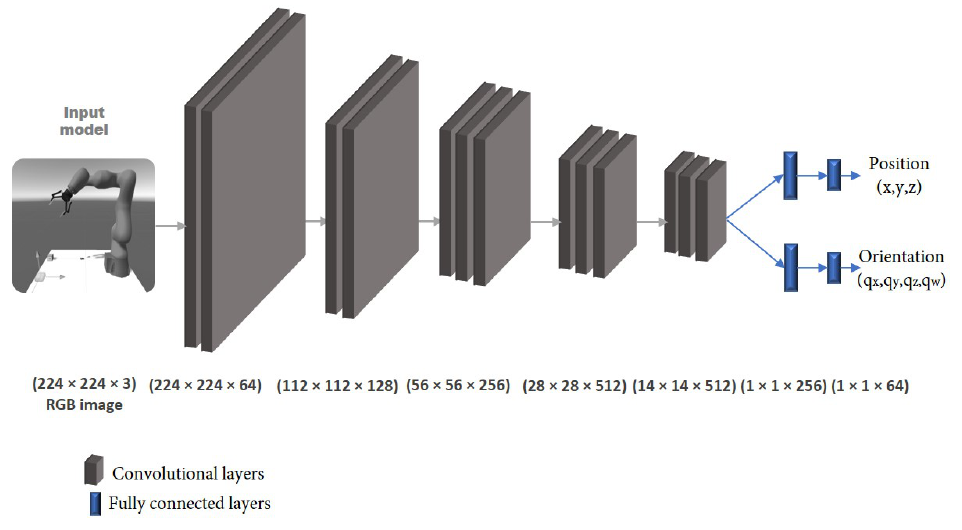
Figure 11. The VGG-16-based CNN architecture of the training